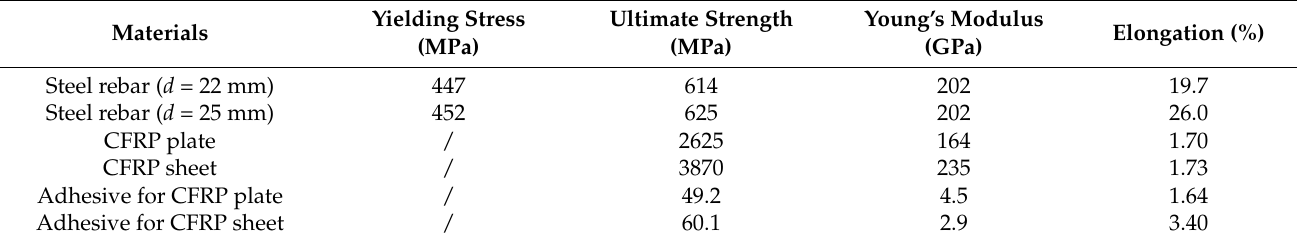
Table 1. Main mechanical properties of